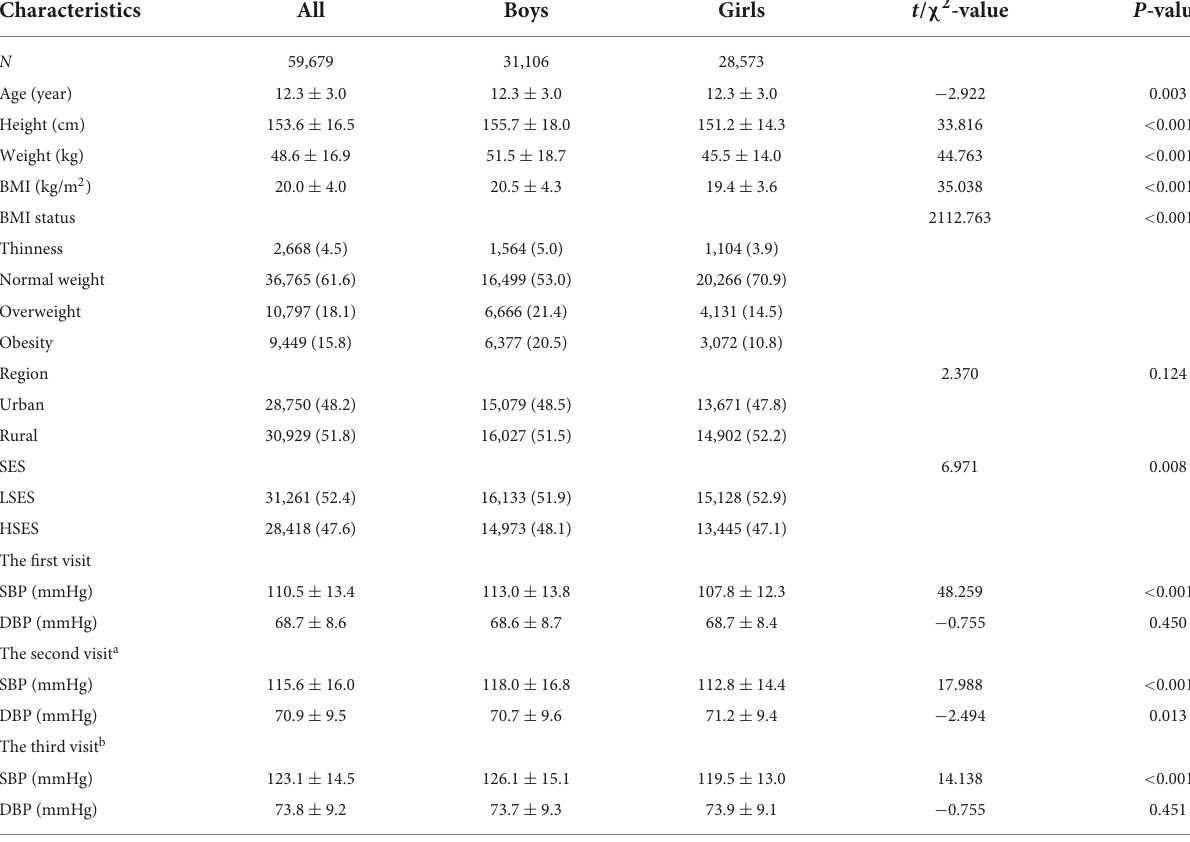
TABLE 1 Basic characteristics of all the participants.